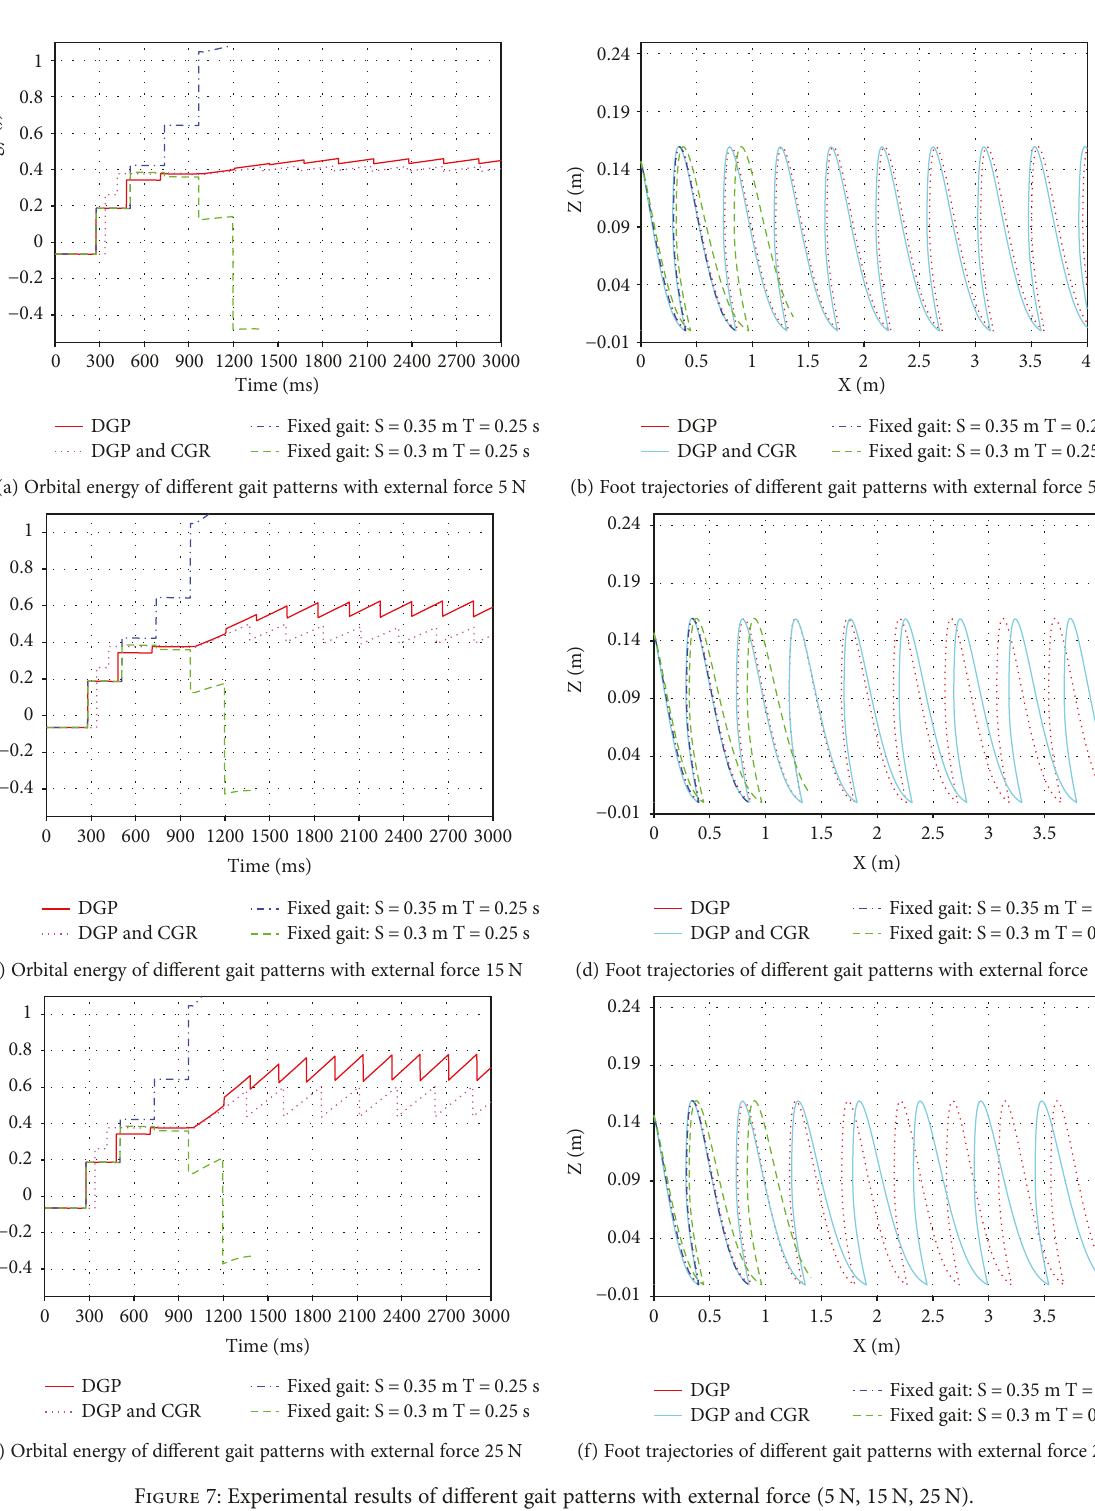
Figure 7: Experimental results of di ff erent gait patterns with external force (5 N, 15N, 25